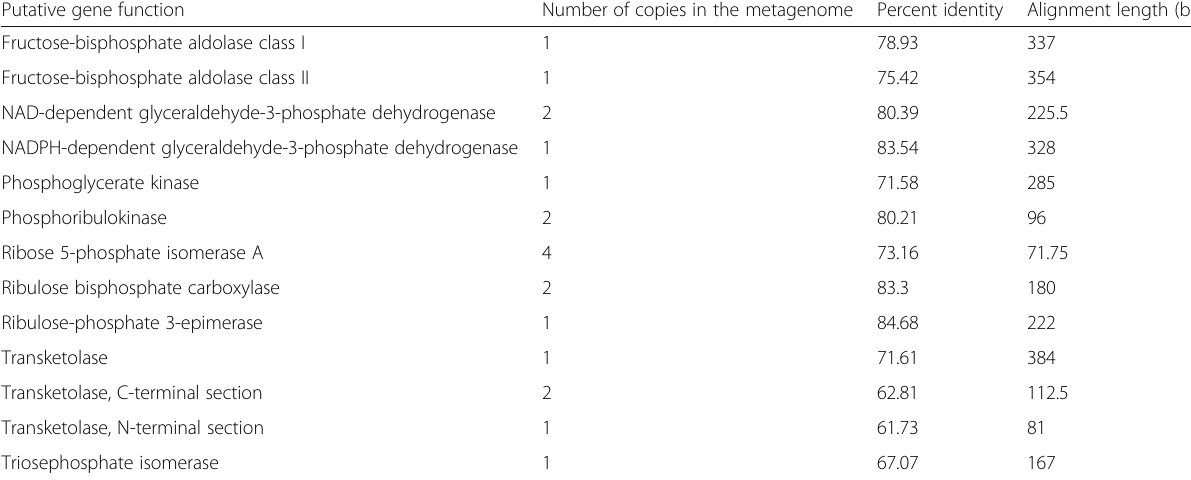
Table 2 Putative gene functions associated with the Calvin-Benson-Bassham Cycle Putative gene function Number of copies in the metagenome Percent identity Alignment length